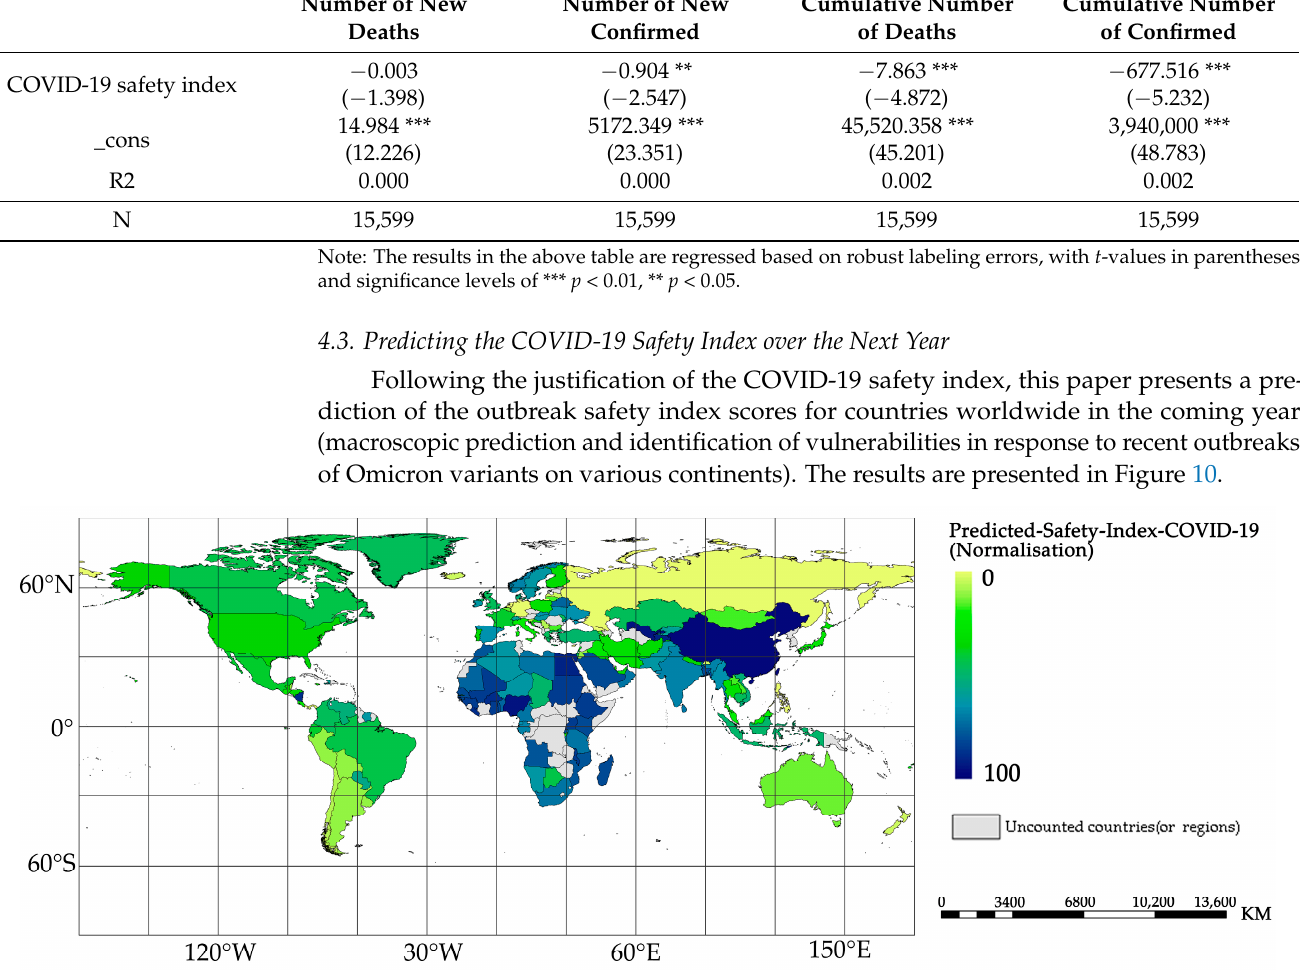
Figure 10. Predicted COVID-19 safety index scores of 150 countries.